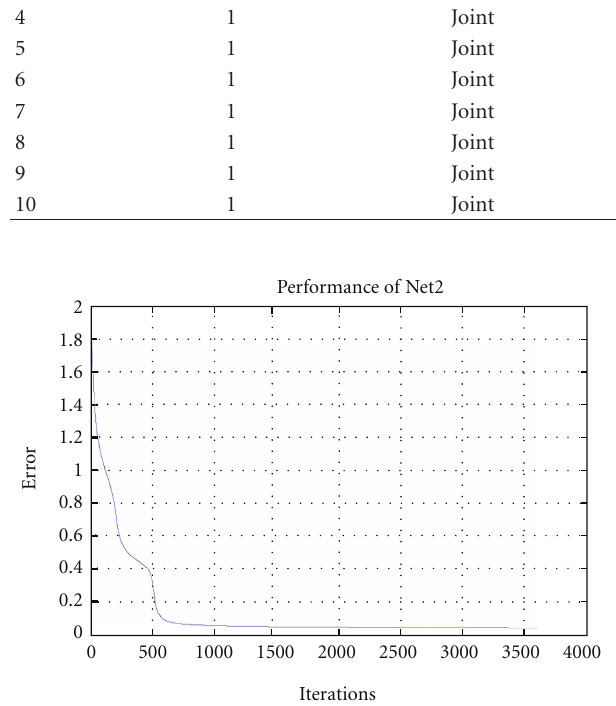
Figure 12: Training of